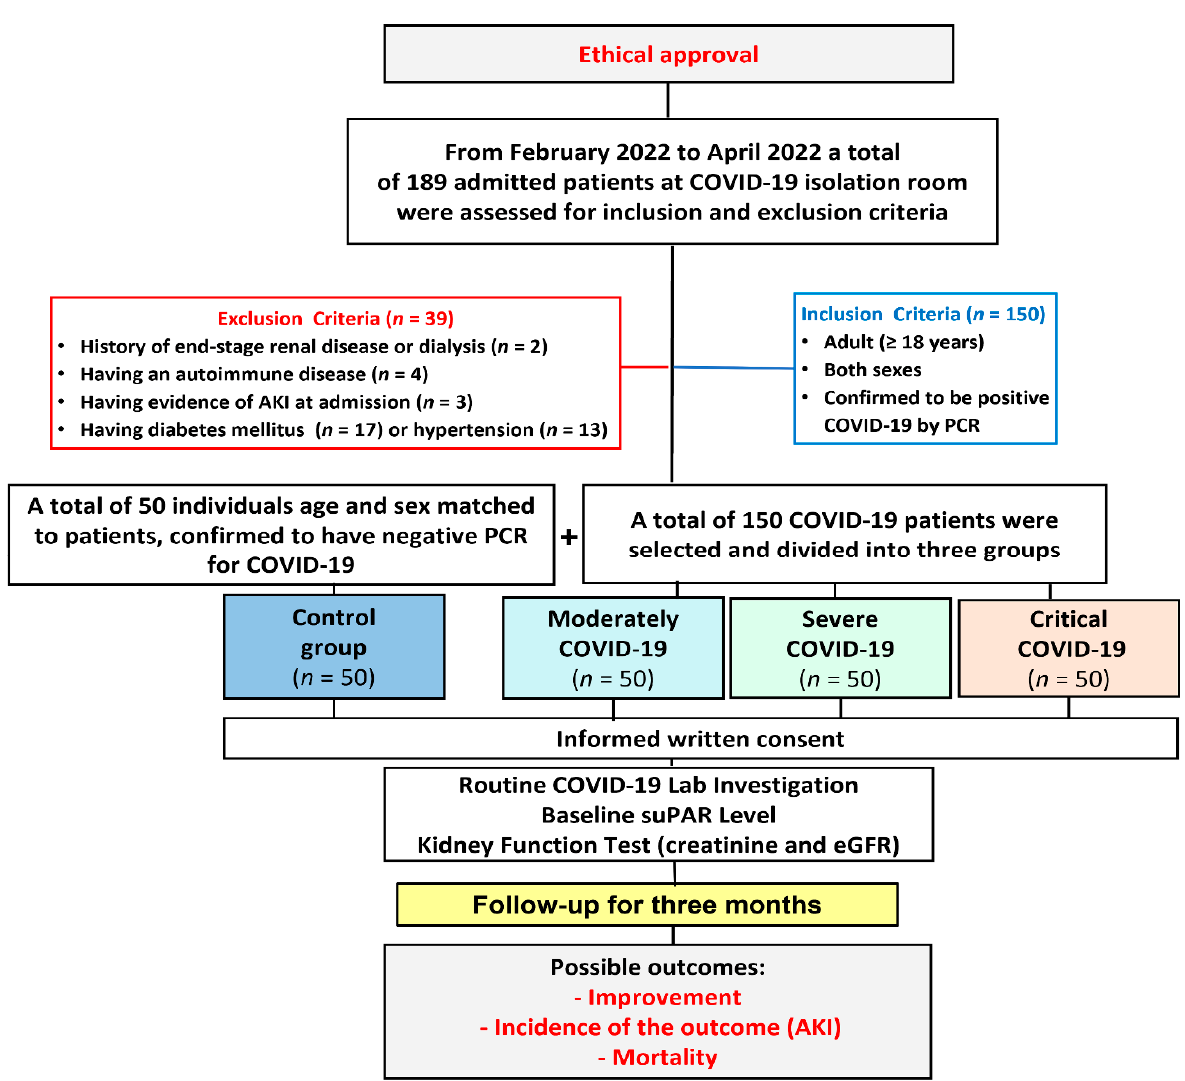
Figure 12. Flowchart of the studied groups and the follow-up until the incidence of the